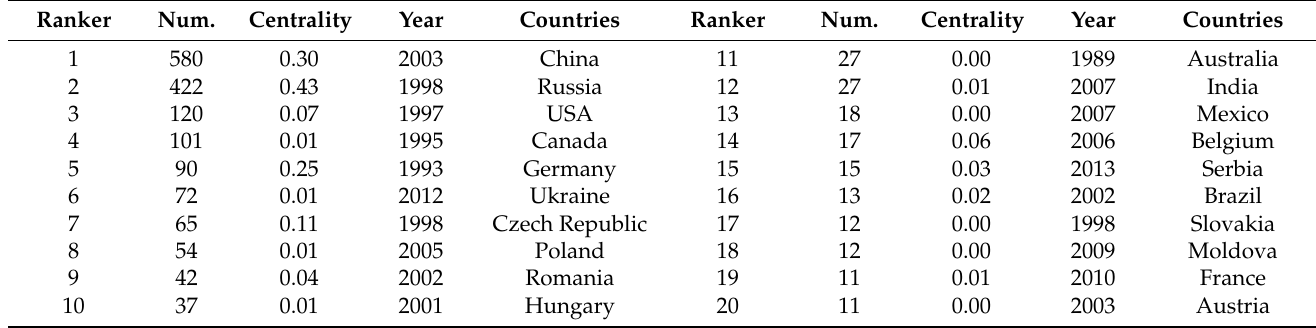
Figure 4. Clustering mapping of country collaboration networks for BSC domain publications. Table 3. Information on the top 20 countries in terms of number of